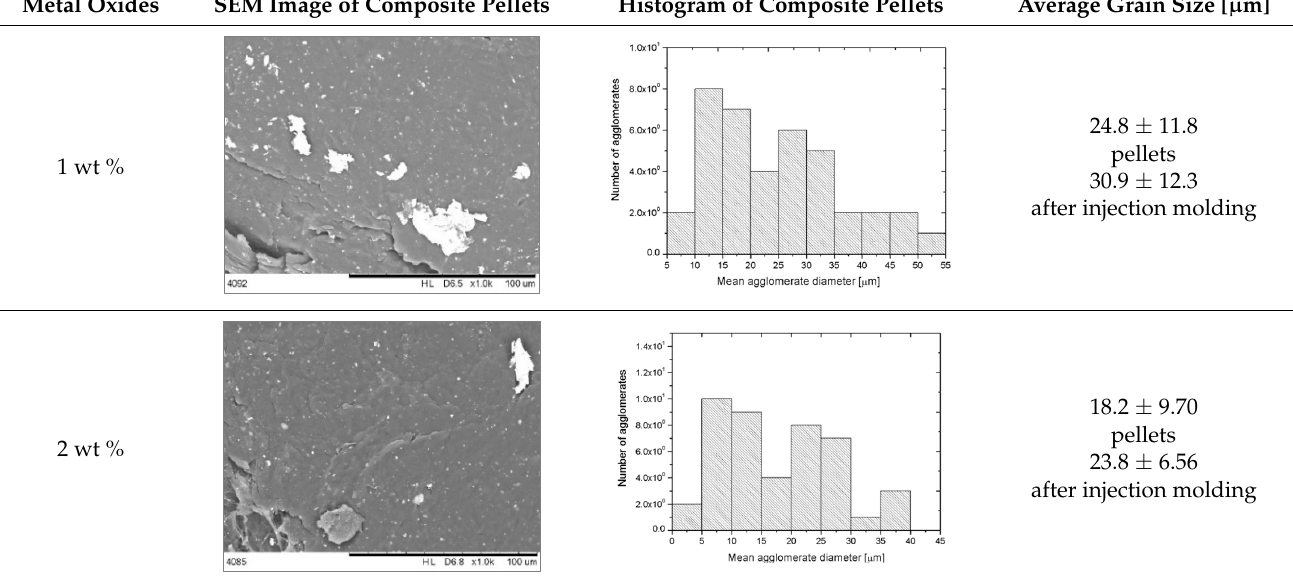
Table 3. The summary of qualitative and quantitative microstructure analysis. Metal Metal Oxides